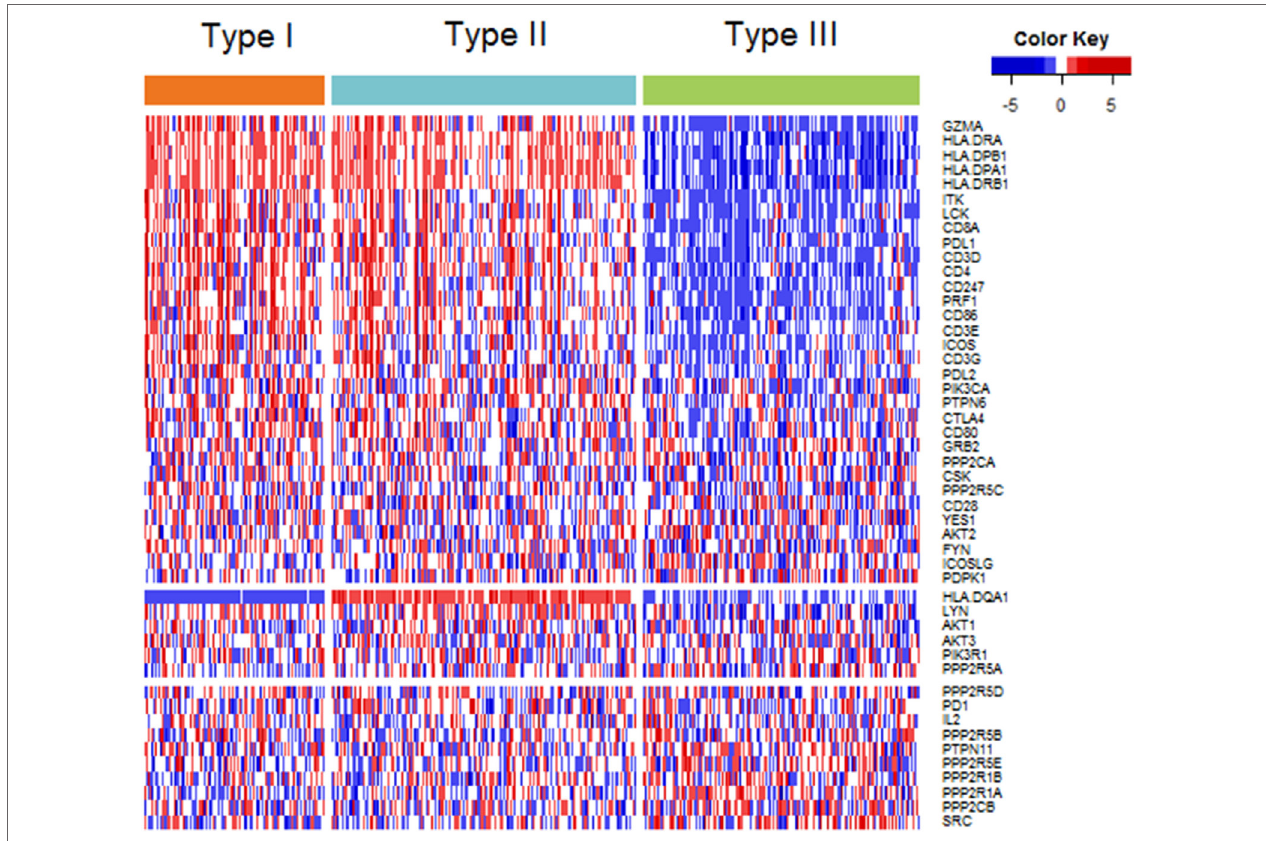
FigUre 2 | Heatmap plot of 48 genes across 3 immune molecular subtypes (IMMSs). Samples were sorted by IMMSs. Genes were divided into three groups according to highest expression in three IMMSs. Red indicated high expression and blue indicated low